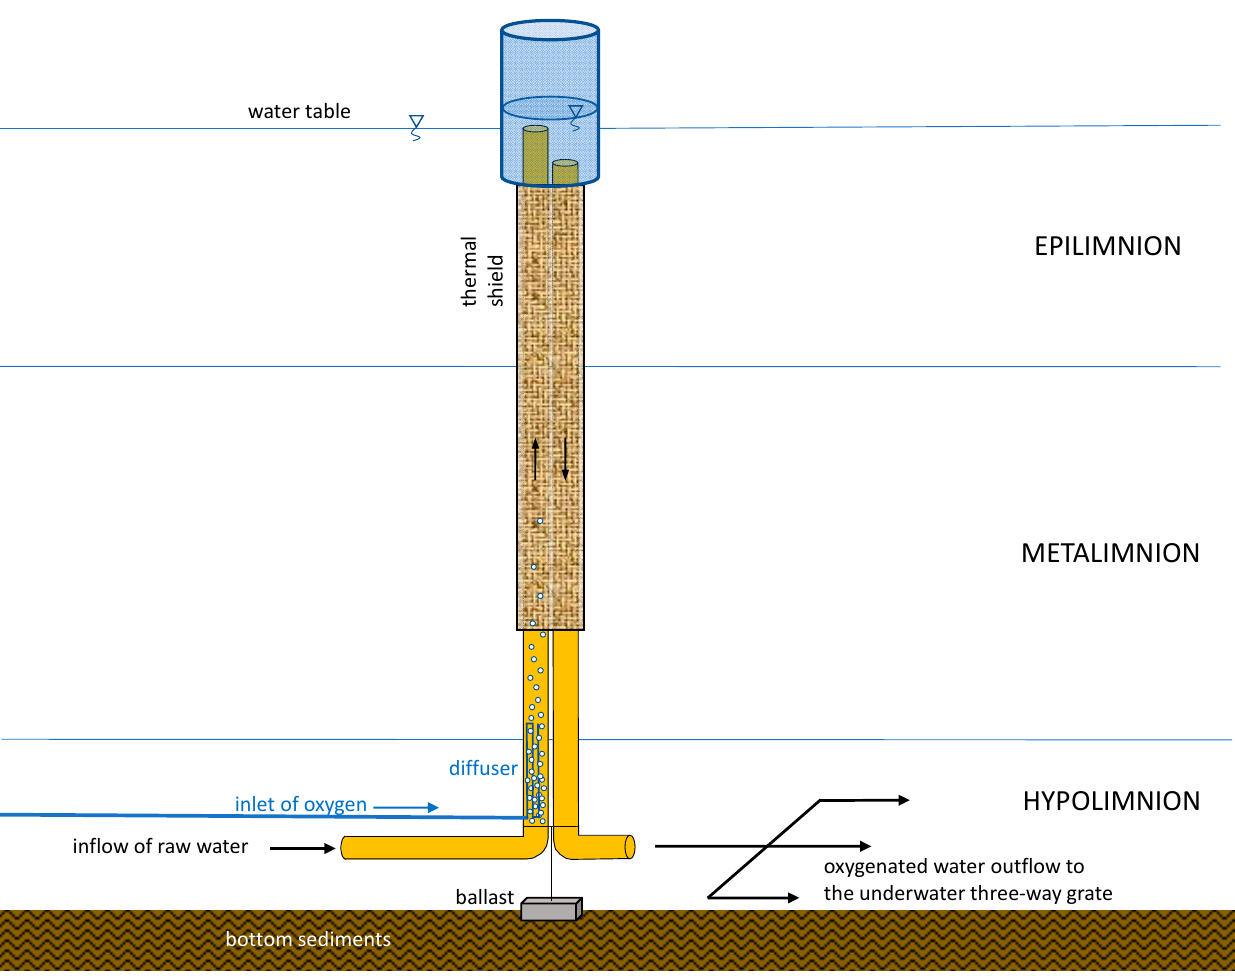
Figure 1. Location of the oxygenation system in Lake Ł ajskie.